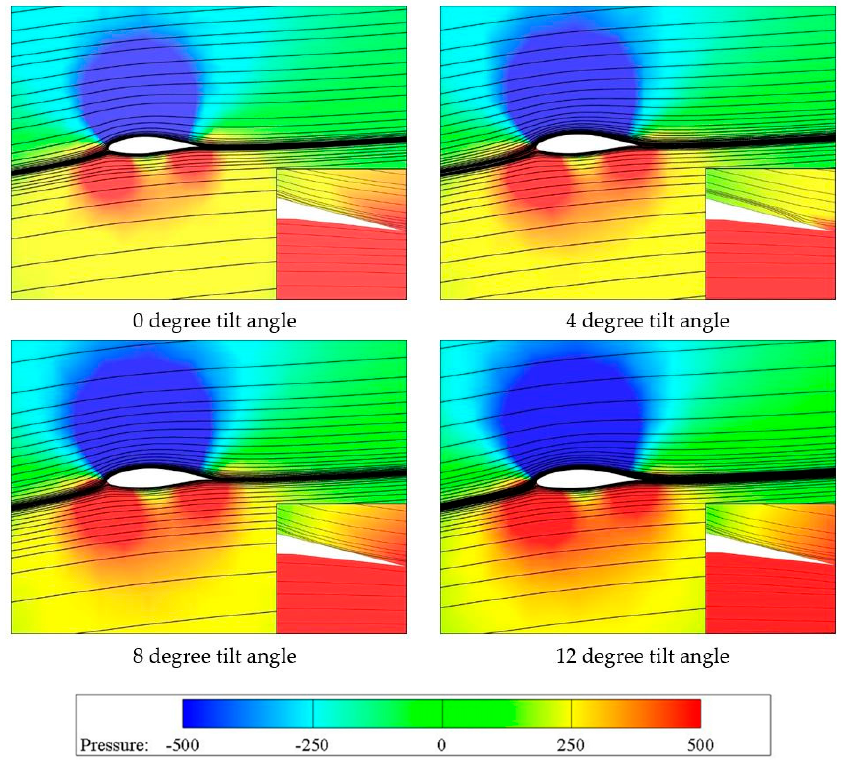
Figure 14. Instantaneous pressure magnitude and streamlines diagram (r/R = 0.9).